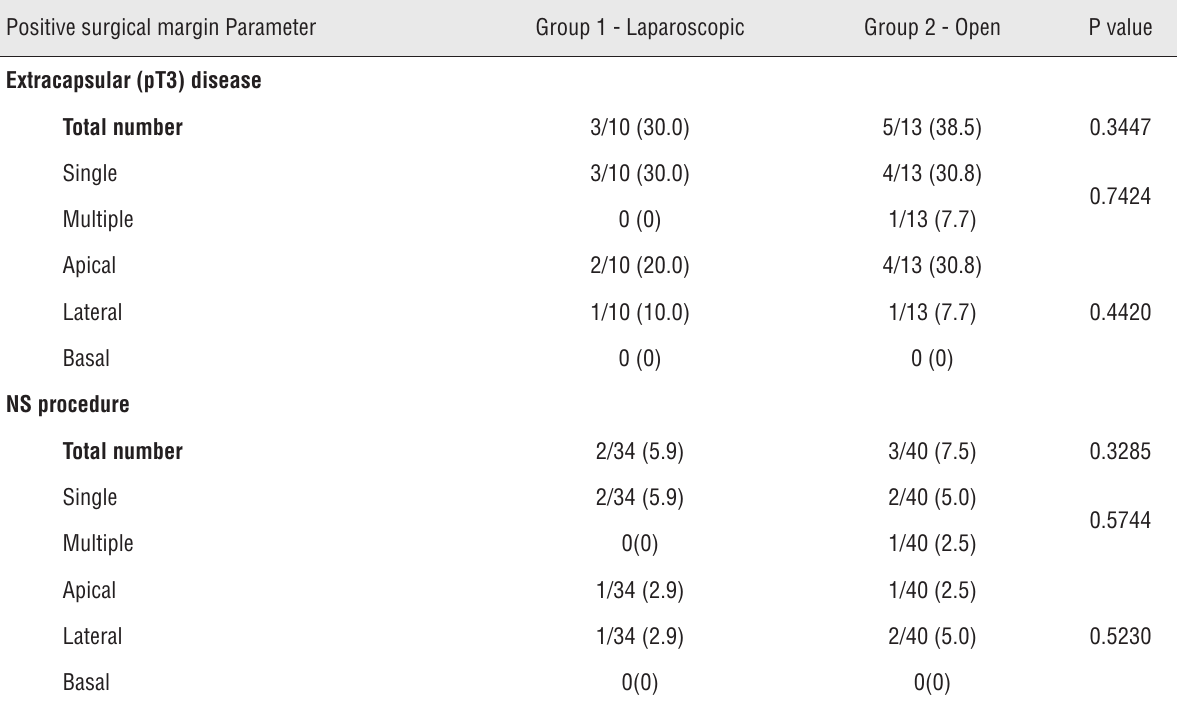
Table 4 - Extracapsular (pT3) cases and ns procedures: distribution and characteristics of positive surgical margins in the two groups. Results are presented as mean ± sD (mean) and range or number (%) of cases.